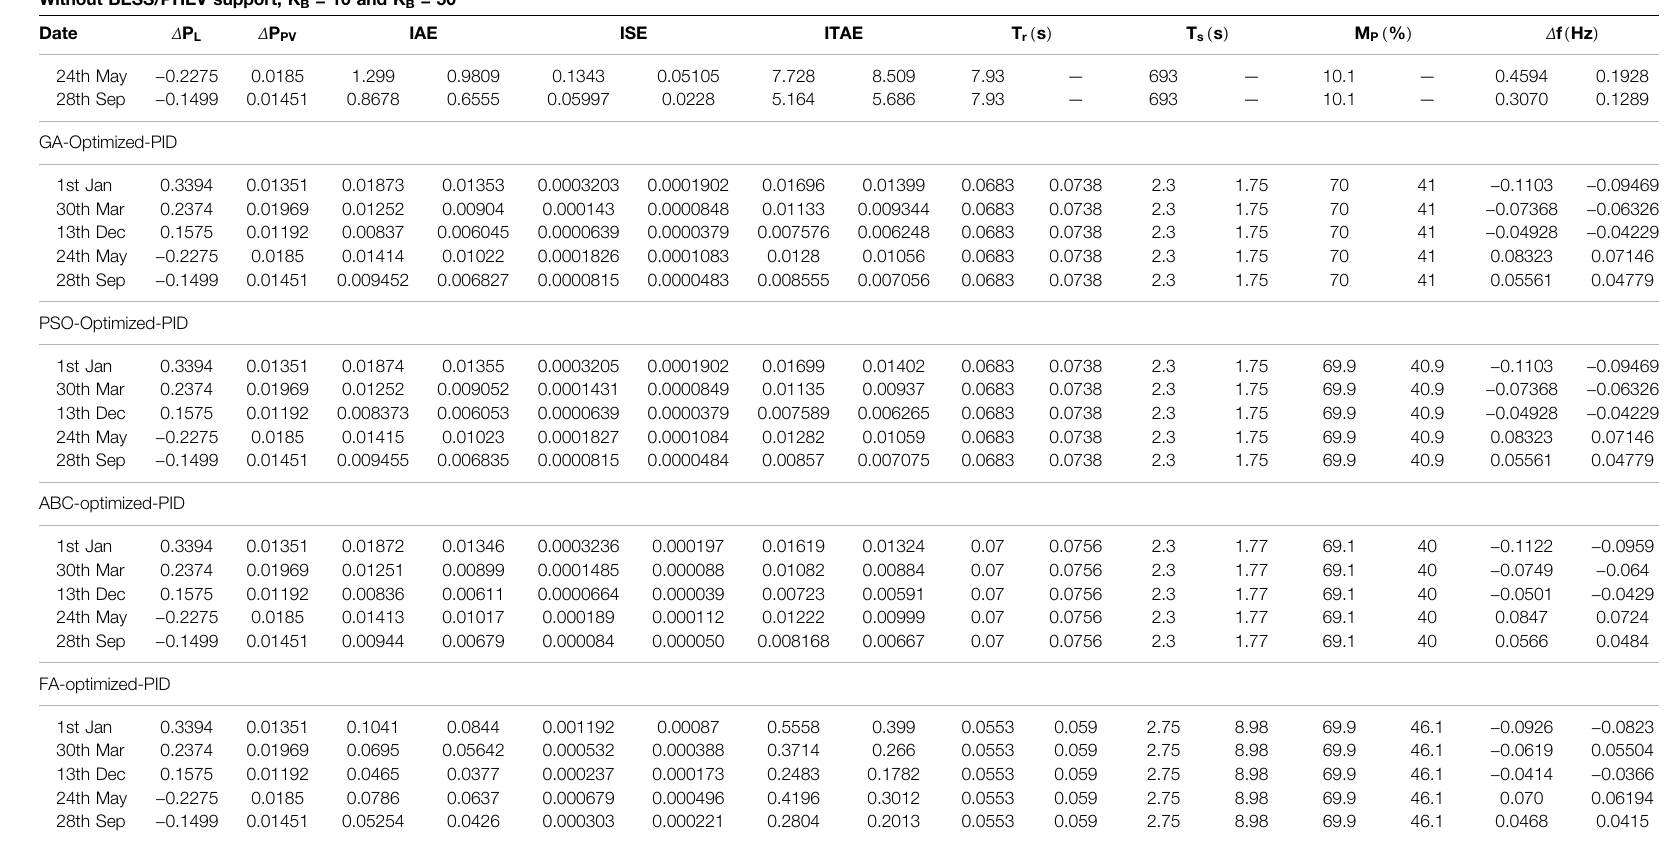
TABLE 6 | ( Continued ) Frequency deviation parameter indices using integral absolute error objective function. Without BESS/PHEV support, K B = 10 and K B =